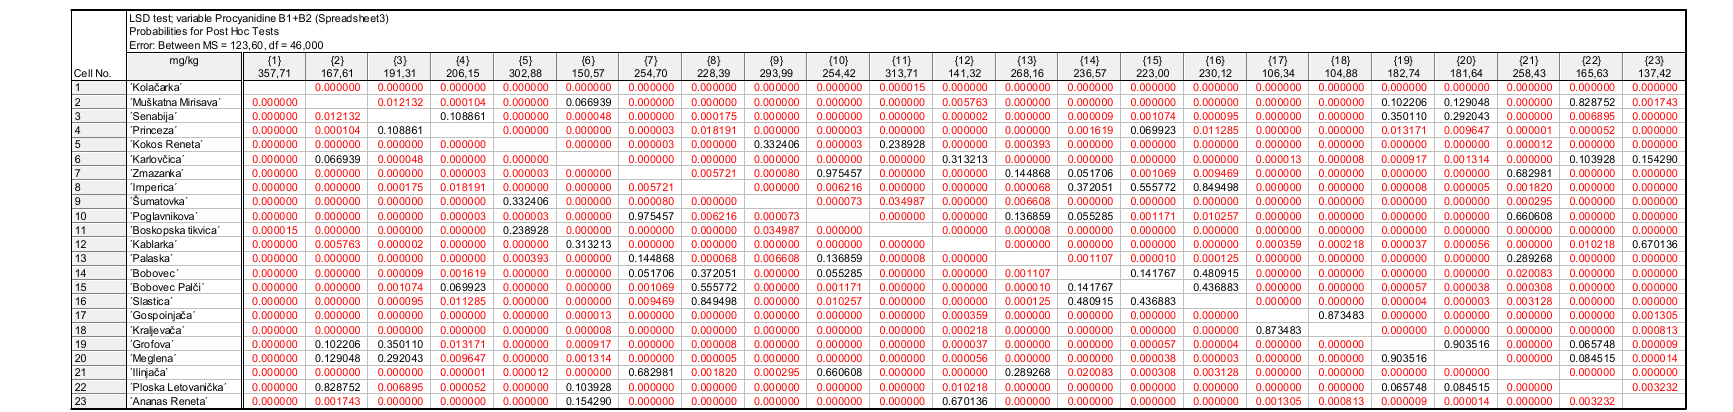
Figure A3. The statistical significance of procyanidin B1 + B2 in traditional apple varieties; the p -values of the correlations of identified polyphenols. Statistically significant p -values are marked red ( p < 0.05).